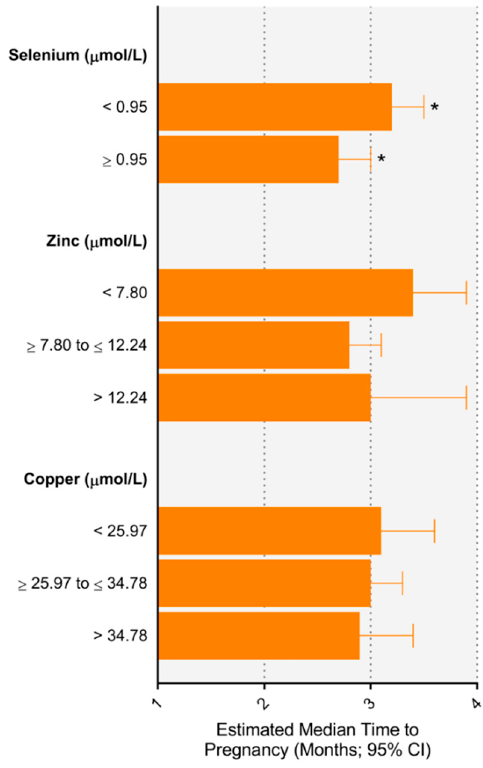
Figure 1. Estimated median time to pregnancy according to maternal trace element concentration.* p < 0.05 between groups.